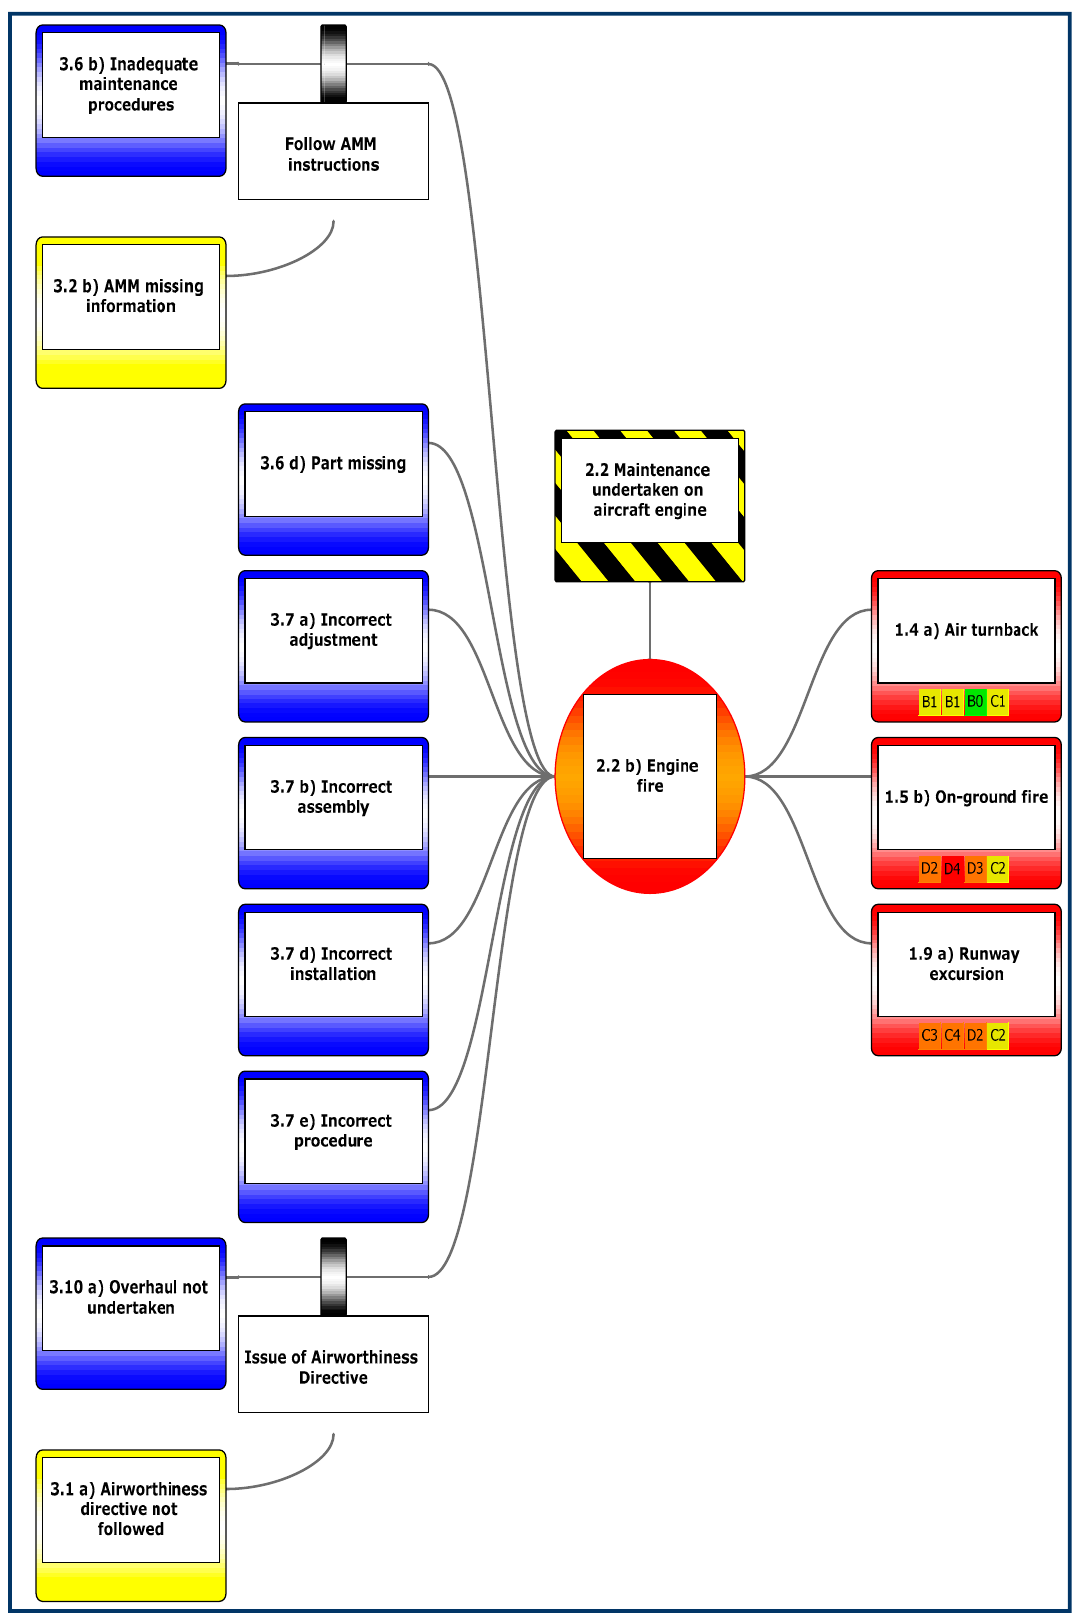
Figure 8. Sample bowtie analysis.